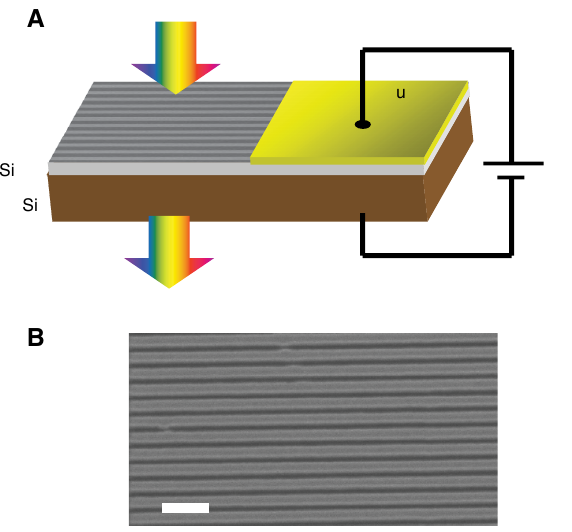
Figure 6 Experimental basics for the tunable phonon-induced transparency in bilayer graphene. (A) Illustration for the gated bilayer graphene nanoribbon device and the infrared measurement. (B) A typical SEM image for a nanoribbon array (A–B adapted with permission from [56], Copyright 2014 American Chemical Society).